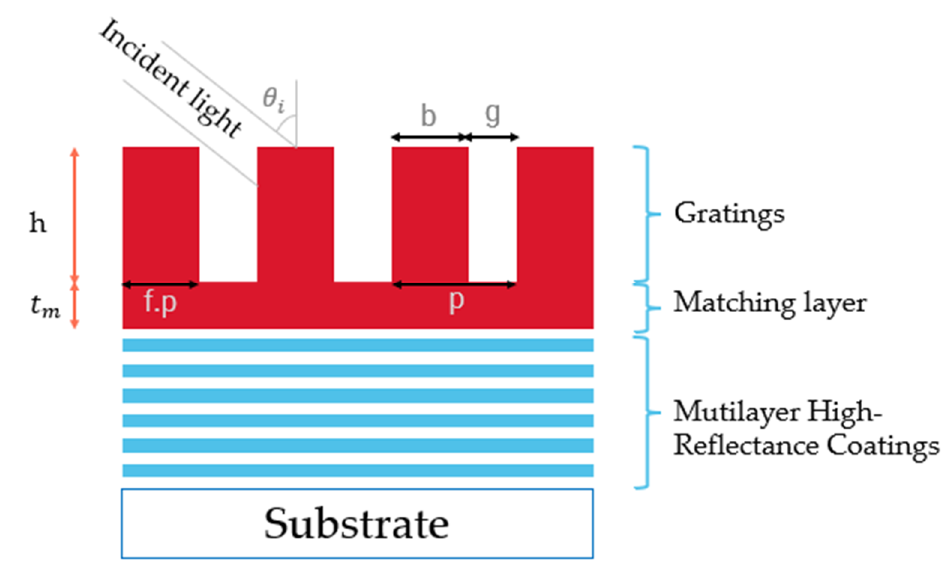
Figure 2. Schematic of MDG.